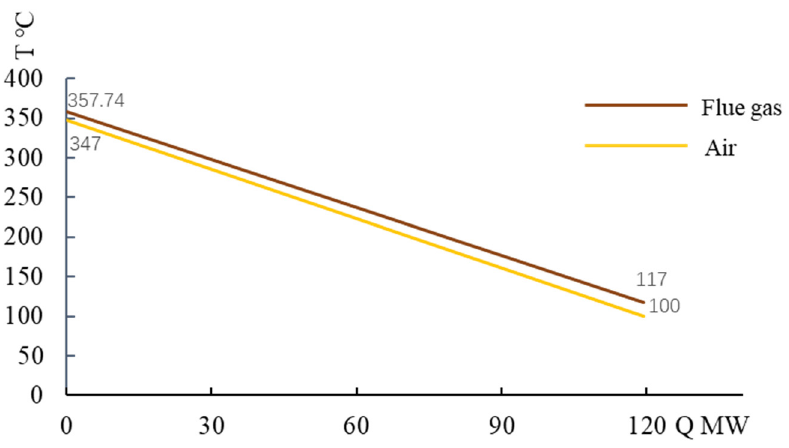
Figure 14. Heat transfer curve of air preheater.